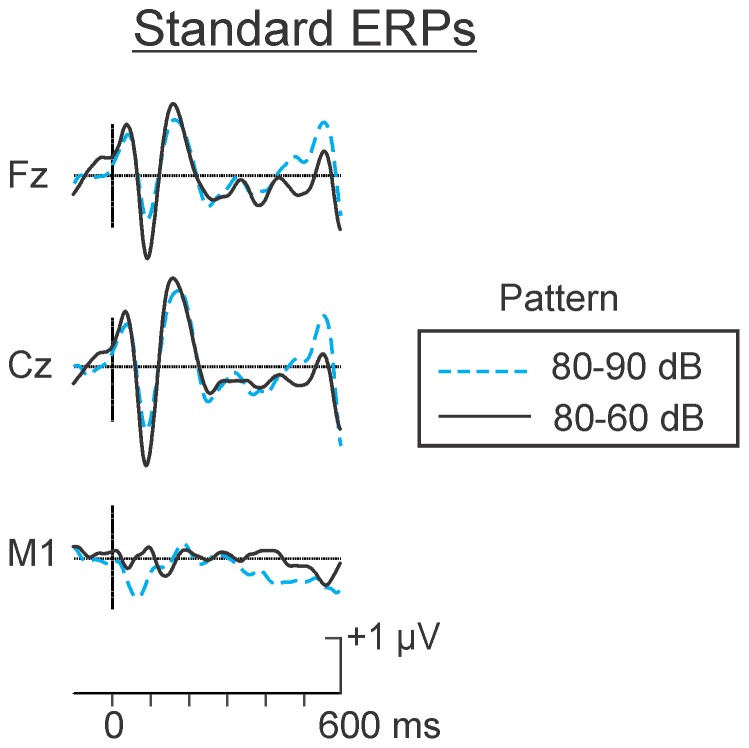
Grand average “raw” ERPs elicited by the same standard 80 dB SPL tones in the psychological increment and decrement conditions.ERPs corresponding to the standards in the two conditions are superimposed in the figure. N1, peaking at about 100(60 dB SPL) tone in the decrement condition but alternated with a higher intensity (90 dB SPL) tone in the increment condition.